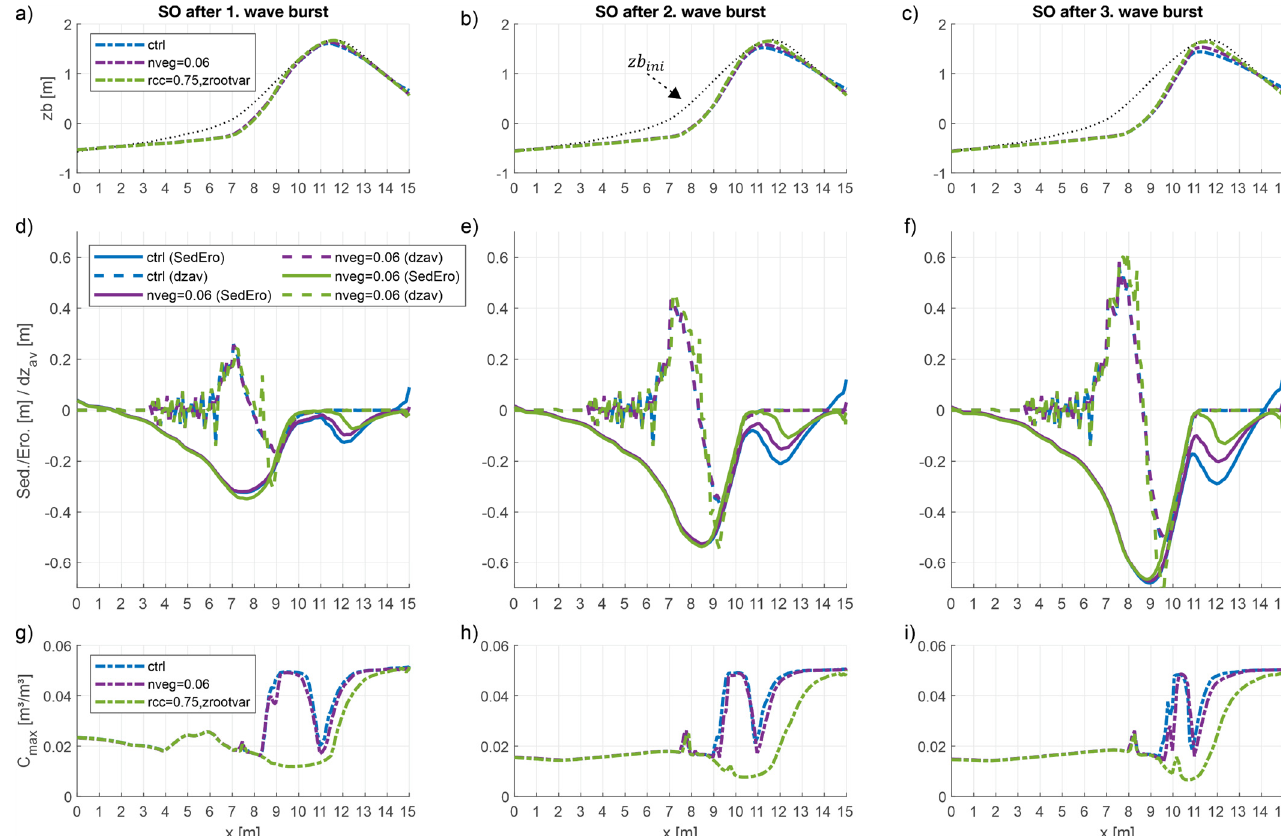
Figure 8. Time evolution of various output parameters for SO including dune profiles after the first ( a ), second ( b ) and third ( c ) wave burst, the cumulative erosion and the bed level change due to avalanching after each wave burst ( d – f ) and the maximum sediment concentration during each respective wave burst ( g – i ).